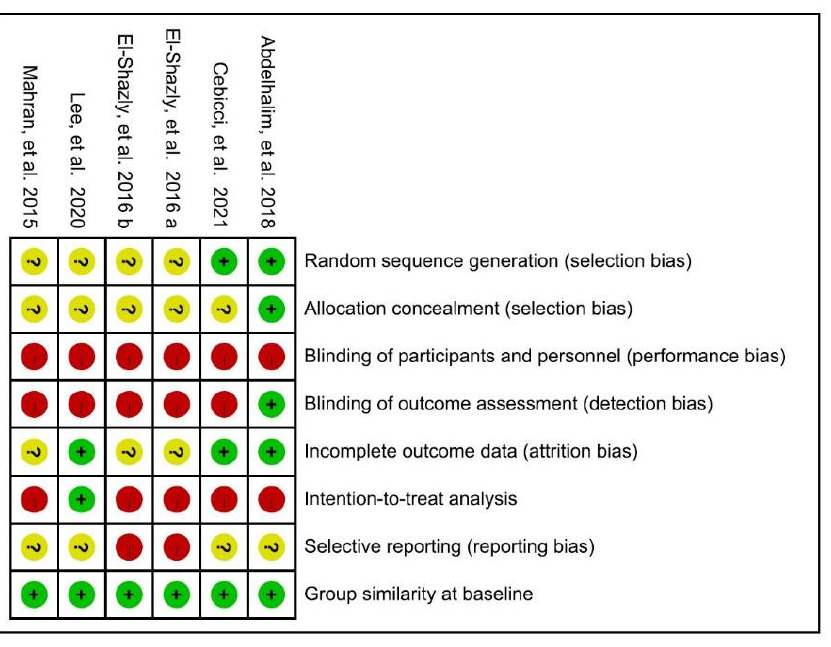
Figure 2. Cochrane risk of bias summary for the included articles. Mahran,et al.2015[38]; Ely- Shazly,et al.2016 a[39] b[40]; Abdelhalim,et al.2018[41]; Lee,et al.2020[42]; Cebicci,et